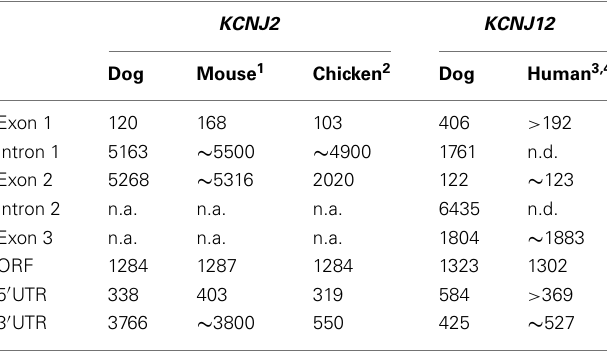
Table 2 | Comparison of canine KCNJ2 and KCNJ12 gene structure with that of other